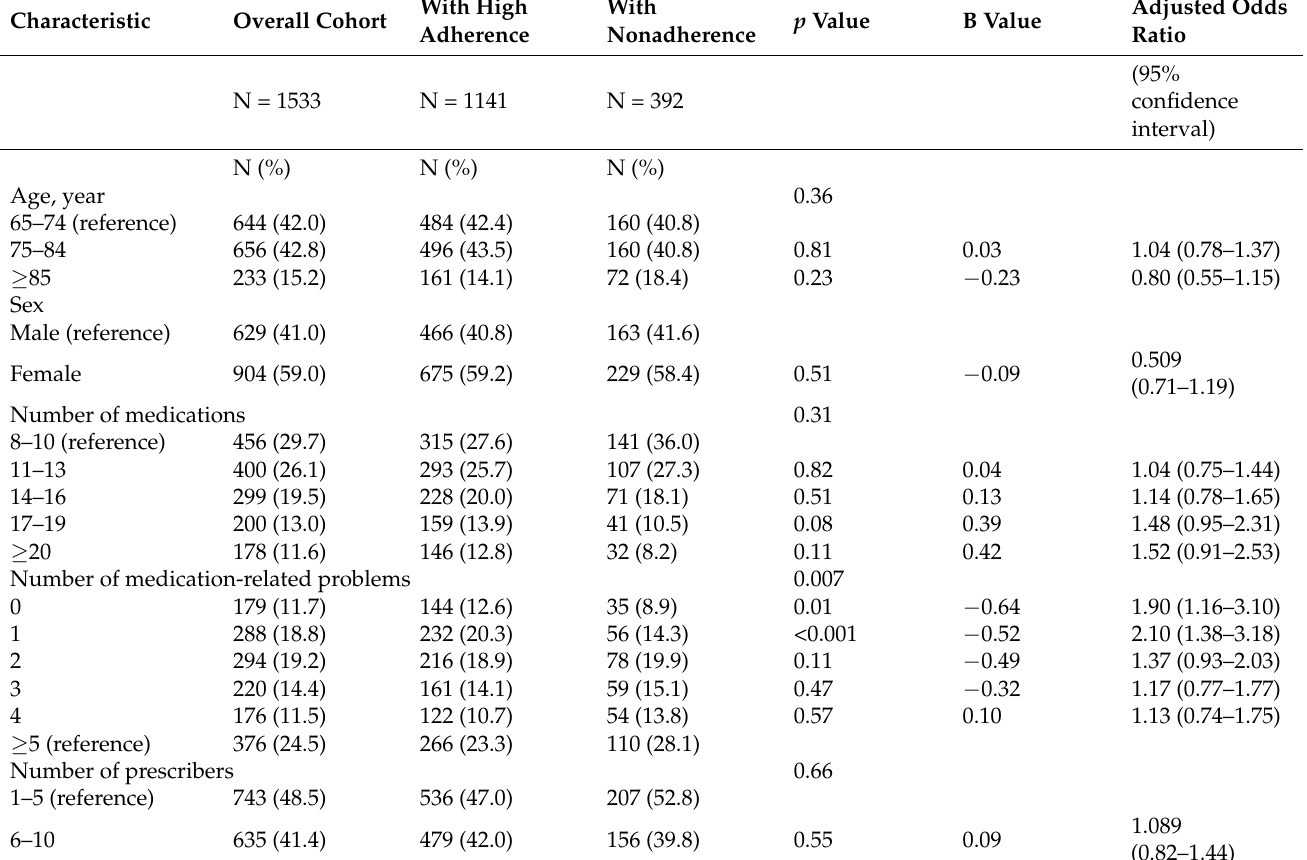
Table 1. Descriptive data and results from logistic regression evaluating the association between patient characteristics and adherence to controller inhalers in 2019 (N =